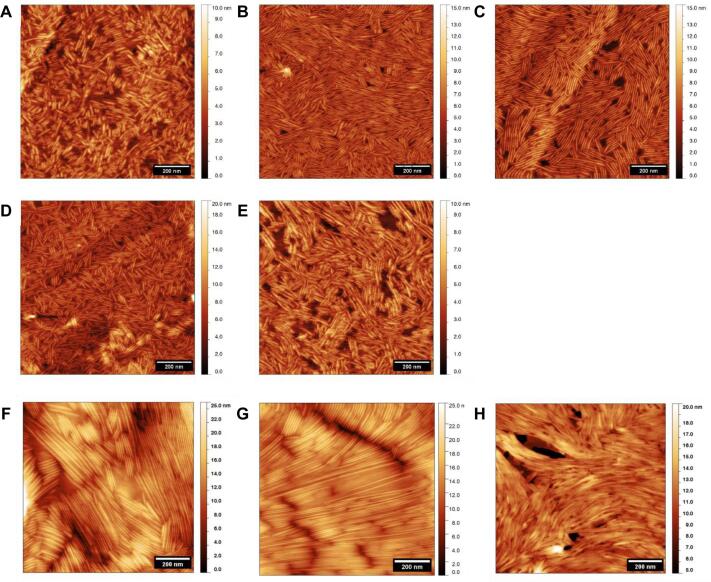
Assembly of RodA WT and mutant proteins on highly oriented pyrolytic graphite. Atomic force micrographs showing the surface morphology of rodlets formed by (A) RodA WT, (B) RodA I114G, (C) RodA I115G, (D) RodA L145G and (E) RodA I146G after incubation at room temperature on graphite surfaces. Surface layers containing rodlets formed by (F) RodA WT, (G) double mutant RodA I115G/I146G and (H) C7C8NC2 chimera after incubation at 50 °C for 2 h. (See the Material and Methods section for the AFM experimental conditions).